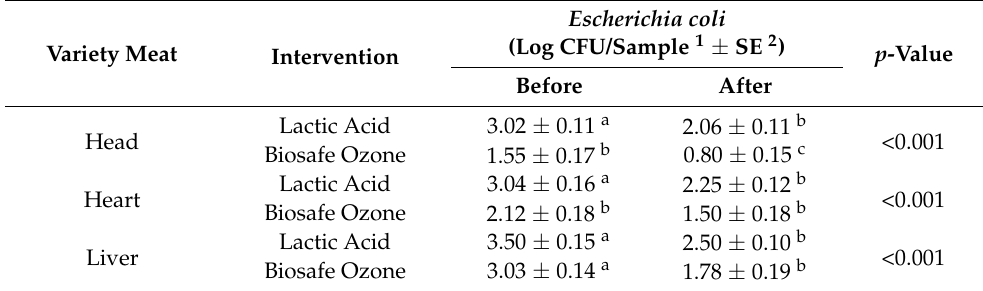
Table 2. Summary table of Escherichia coli counts in all variety meats before and after lactic acid and biosafe ozone interventions.